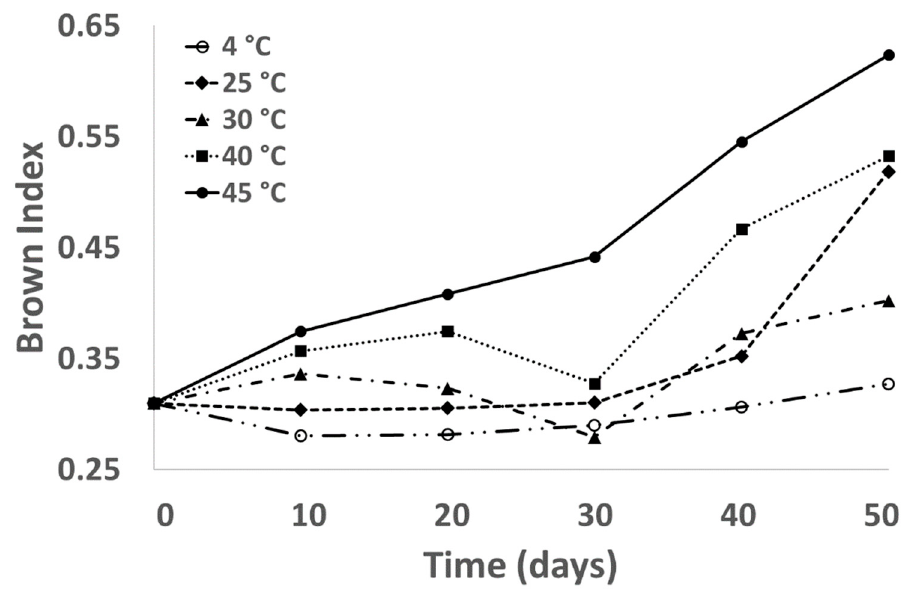
Figure 5. Evolution of the brown index during storage in the dark of samples of cactus pear juice at different temperatures.